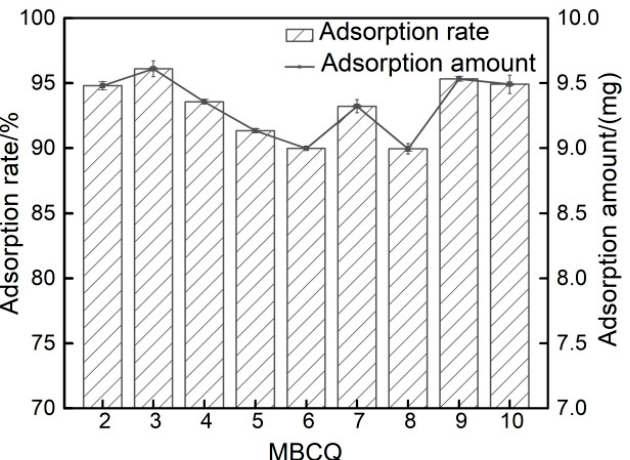
Figure 3. Static adsorption of Ph by biochar. Table 2. Estimated parameters of the traditional adsorption isotherm